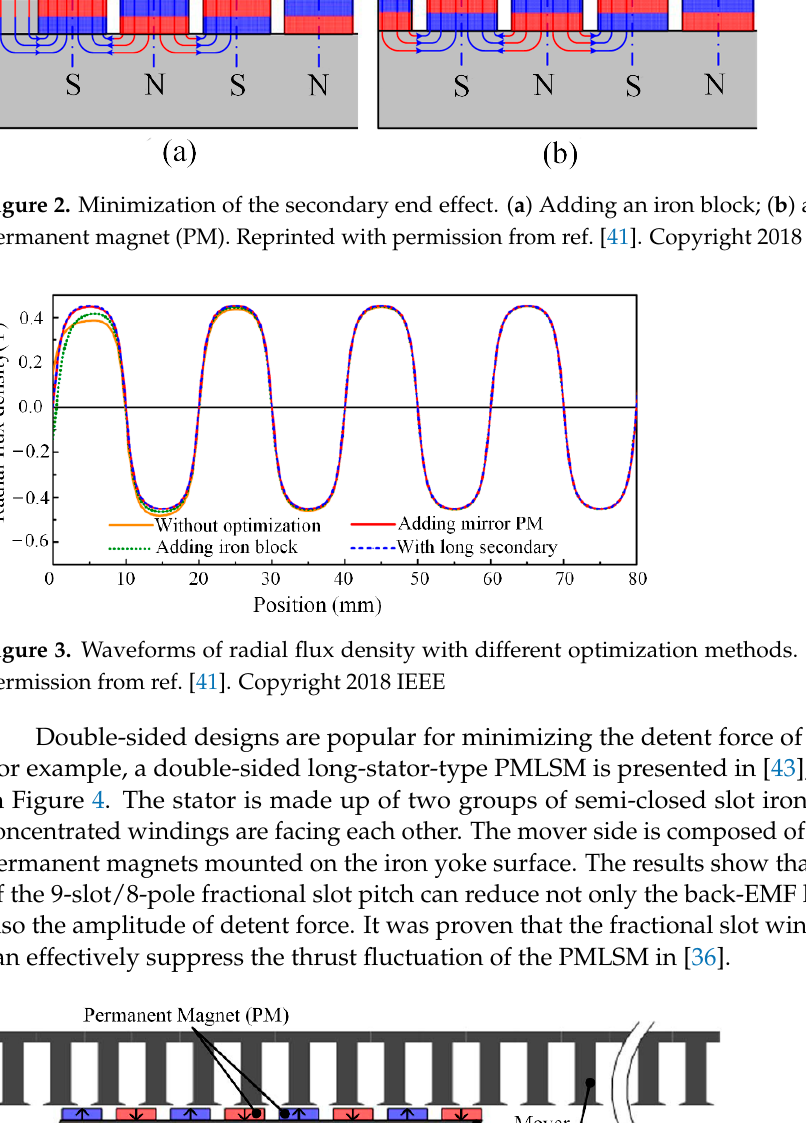
Figure 4. Structure of a double-sided long-stator-type permanent magnet linear synchronous mo- tor (PMLSM). Reprinted with permission from ref. [43]. Copyright 2014 IEEE.